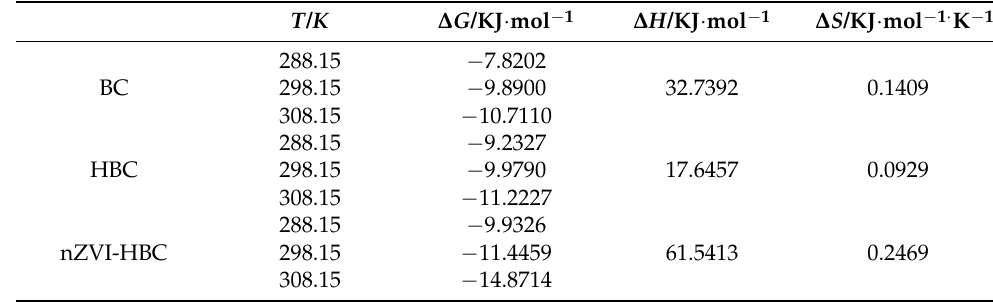
Table 2. Thermodynamic parameters of OTC adsorption of BC, HBC, and nZVI-HBC.